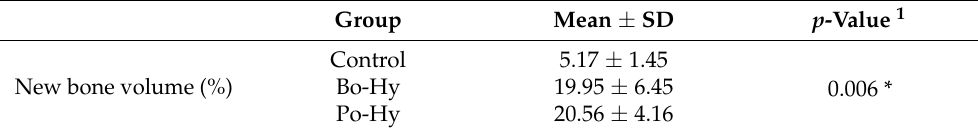
Figure 11. The percentage of new bone volume between the three groups determined by micro-CT analysis (ns: non-significant, *: p < 0.05). Differences between the two xenograft groups were not statistically significant. Table 3. Micro-CT analysis results of new bone volume for all samples at 8